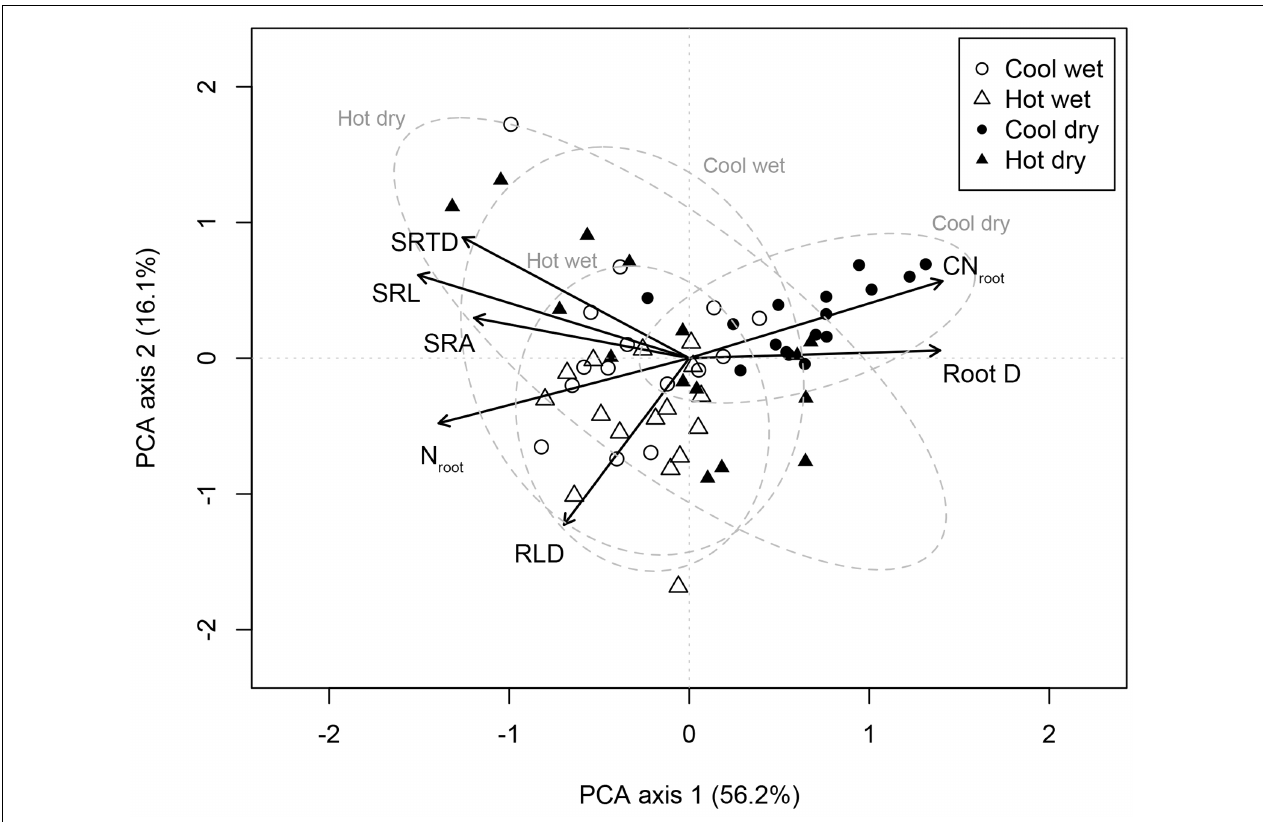
FIGURE 1 | Principal components analysis of intraspecific variation in root functional traits in Coffea arabica . The PCA is based on root traits measured on 62 individual-plants, sampled across four different sites (open circles = CW, open triangles = HW, closed circles = CD, and closed triangles = HD). Dashed lines correspond to 95% confidence ellipses for C . arabica roots sampled at each site. PCA axis 1 scores were significantly different ( p < 0.001) for CD as compared to CW, HW, and HD.